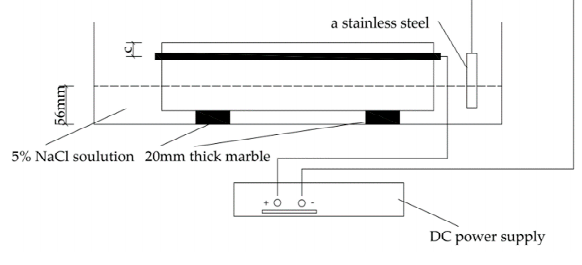
Figure 2. Experimental setup.